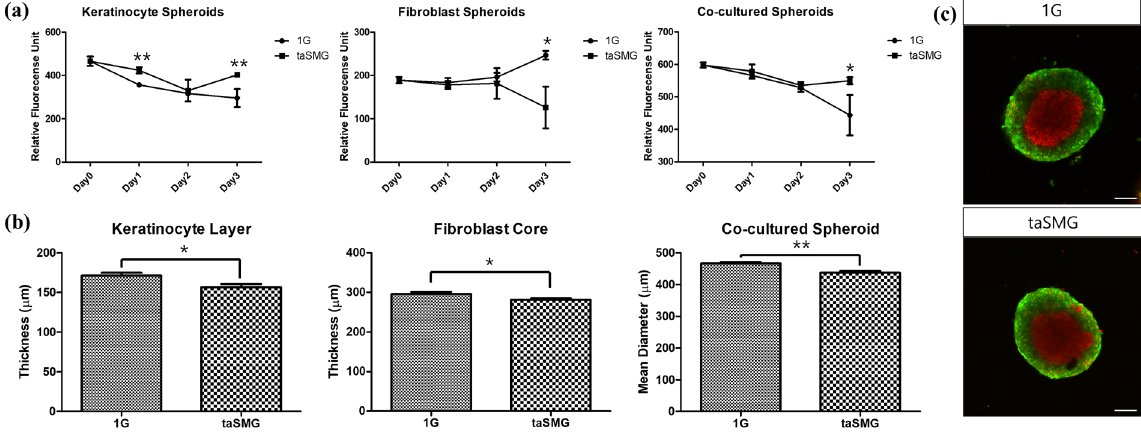
Fig. 2 Cell viability and thickness of spheroids under 1 G and taSMG. a Cell viability of mono- and co-cultured spheroids for 3 days of culture. Keratinocyte spheroids showed signi fi cant difference at day 1 and 3. All spheroids showed a signi fi cant difference after 3 days. b Thickness between keratinocyte layer and fi broblast core and overall diameter of co-cultured spheroids. All comparisons between 1 G and taSMG showed signi fi cant differences after 3 days. Data represent the mean ± SEM ( n = 8, * p < 0.05, ** p < 0.01). c Confocal images of CellTracker TM stained spheroids under 1 G and taSMG. Red tracker indicates fi broblast core and green tracker indicates keratinocyte layer. Scale bars: 100 μ